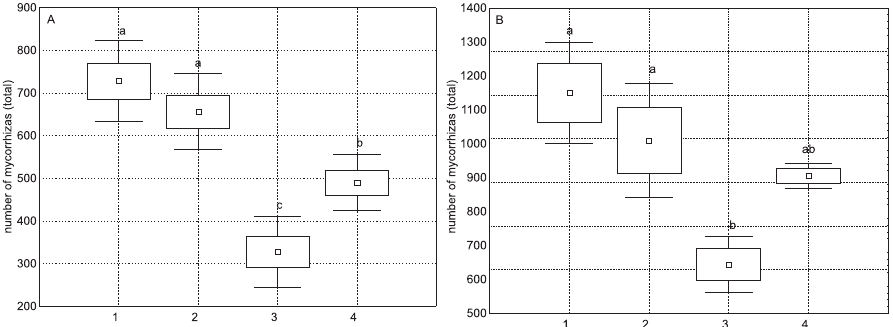
Fig. 1. Number of mycorrhizas on Scot pine seedlings: A first growing season, B the second growing season. Statistically significant differences between the treatments (1 high N and in oculation, 2 low N and inoculation, 3 high N without inoculation, 4 low N without inocula tion) are designated by different letters. Error bars indicate standard error of the mean.